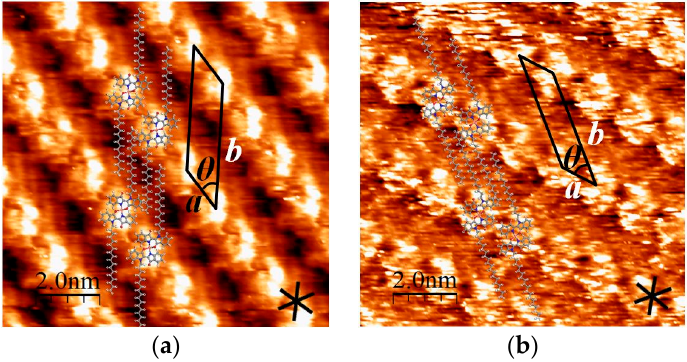
Figure 5. ( a ) STM image and structural model of self-assembled [Cu(C18IND) 2 ] at a HOPG/o-dichlorobenzene interface. Image area: 10 × 10 nm 2 ; V set = 1.41 V, I set = 697 pA; unit cell parameters: a = 1.5 nm, b = 3.7 nm, θ = 41°; ( b ) STM image and structural model of [Cu(C20IND) 2 ]. Image area: 10 × 10 nm 2 ; V set = 1.41 V, I set = 697 pA; unit cell parameters: a = 1.4 nm, b = 4.0 nm, θ = 40°.